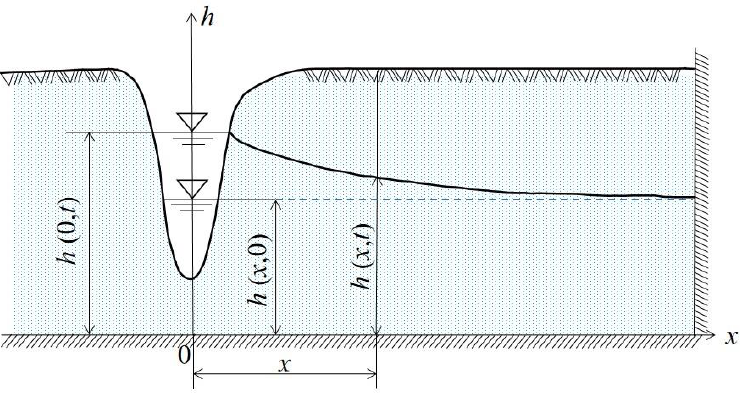
Figure 1. Conceptual model of groundwater flow near the riverbank.